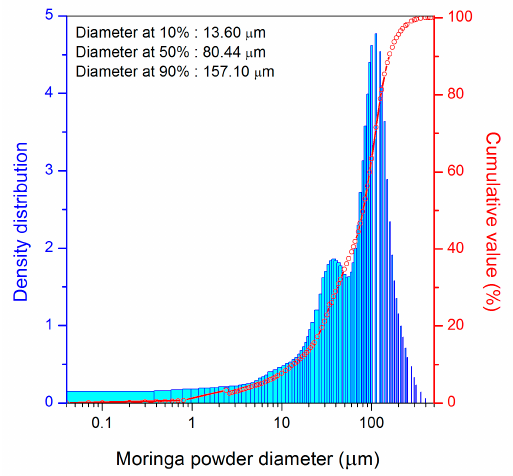
Figure 2. M. oleifera powder diameter distribution as measured by particle size analyzer. The density distribution shown in blue, while cumulative percentage shown in red.